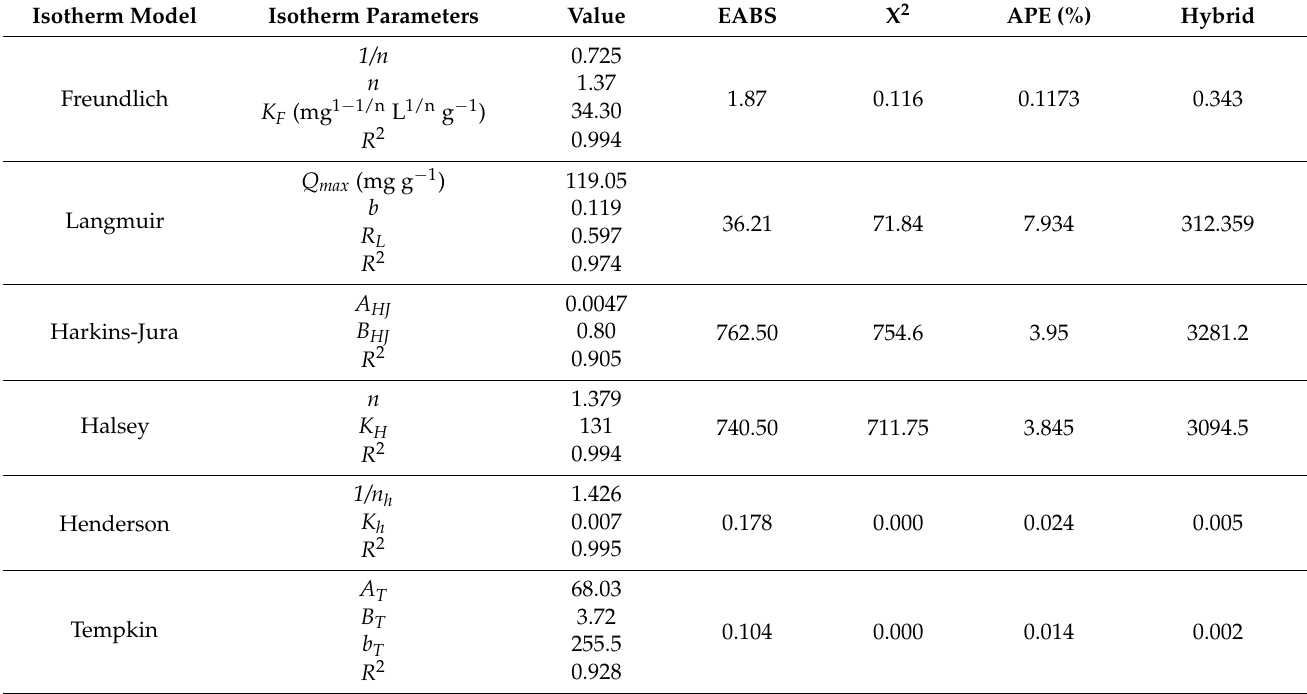
Table 4. Parameters and error function of the isotherm models for IV2R removal by ZnO-NPs. Isotherm Model